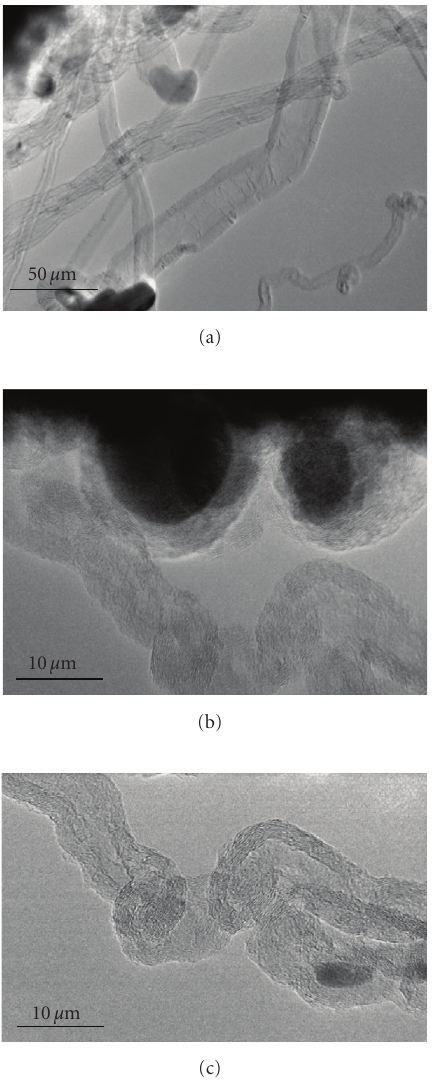
Figure 11: TEM images of carbon nanostructures observed for samples with iron deposition carried out via DC magnetron